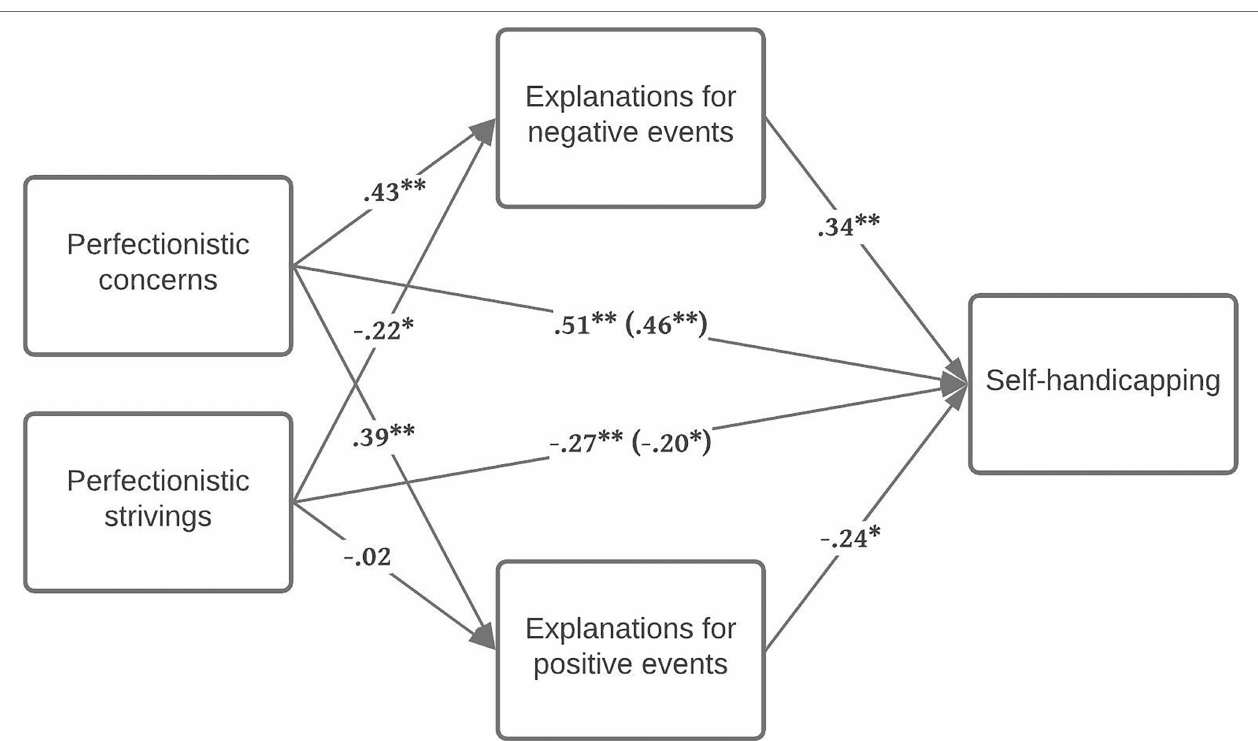
FIGURE 1 | Explanations for positive and negative events as mediators of the effect of the adaptive (striving) and the maladaptive (concerns) aspects of perfectionism on self-handicapping tendencies. Path values represent standardized coefficients. * p < 0.05, ** p <